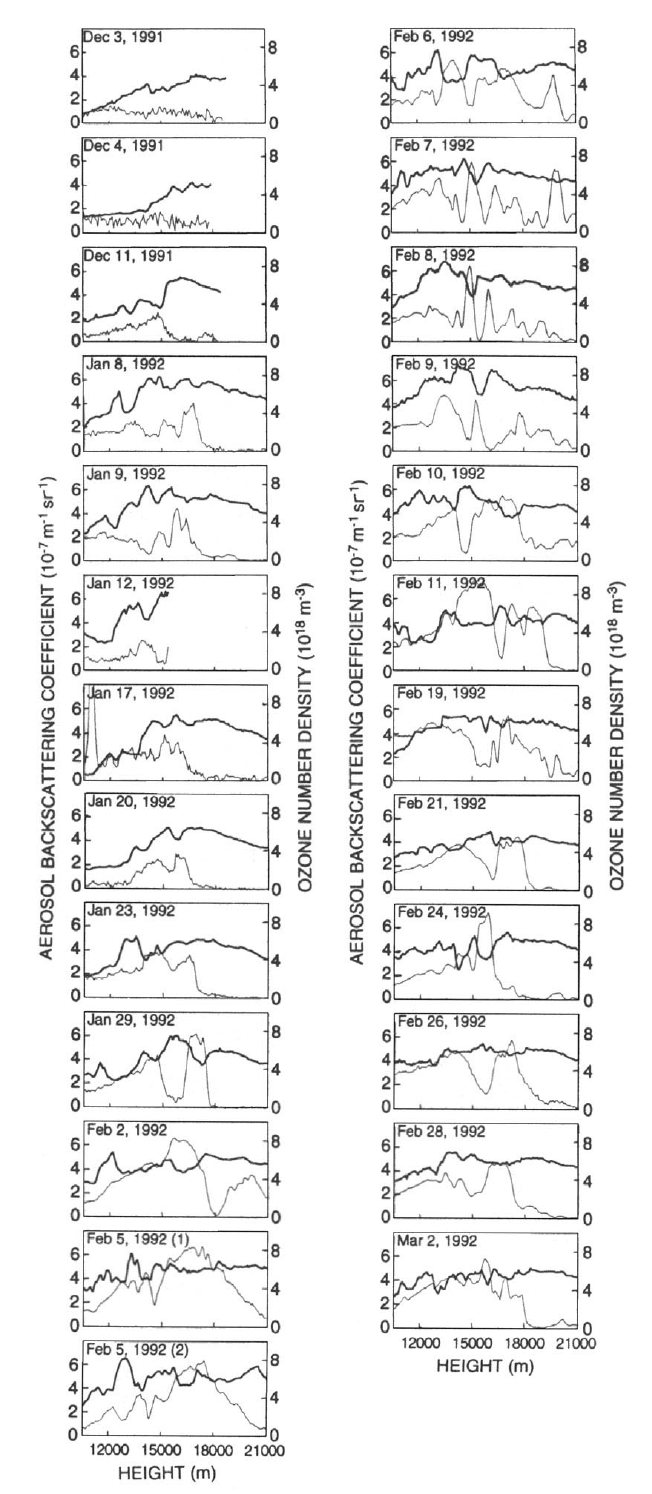
Fig. 4. Sequence of vertical profi les of aerosol back- scattering (thin line) and ozone number density (heavy line), observed with lidar at Thule from December 3, 1991 to March 2, 1992 (di Sarra et al. ,